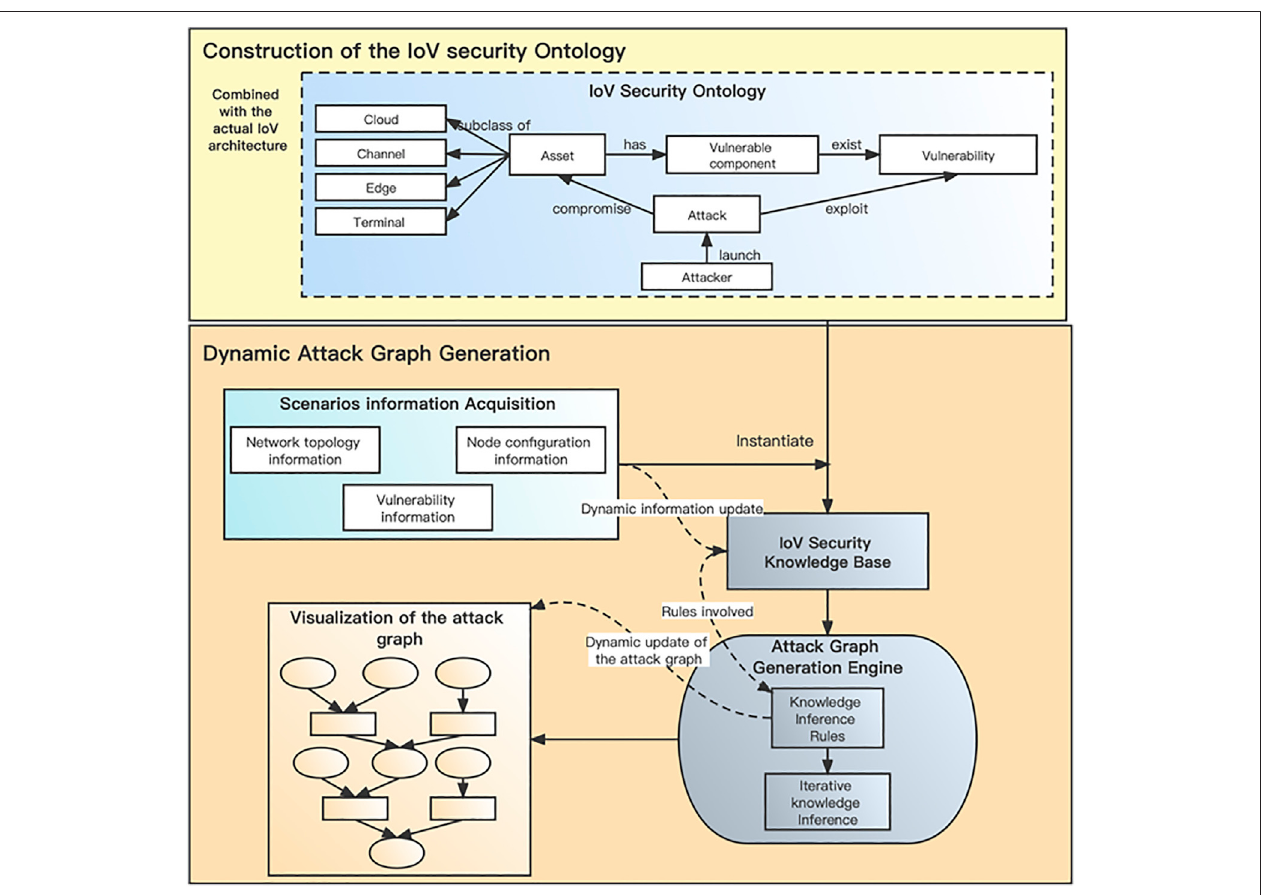
FIGURE 2 | IoV attack graph generation